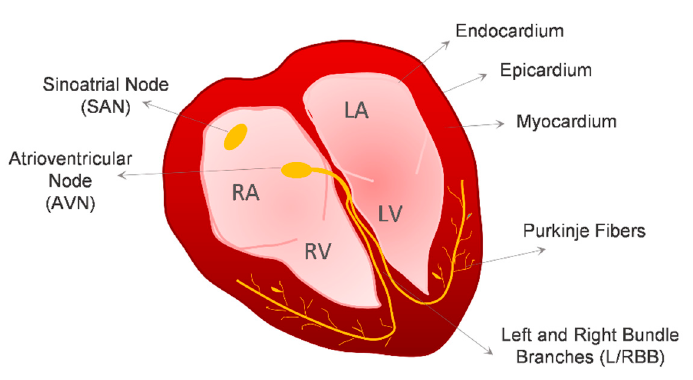
Figure 1. Schematic representation of the human adult heart. Highlighted is the cardiac condition system composed by sinoatrial node (SAN), atrioventricular node (AVN), Left and Right Bundle Branches (LBB and RBB); and heart wall, composed of three different cell layers, the myocardium, the epicardium and the endocardium.